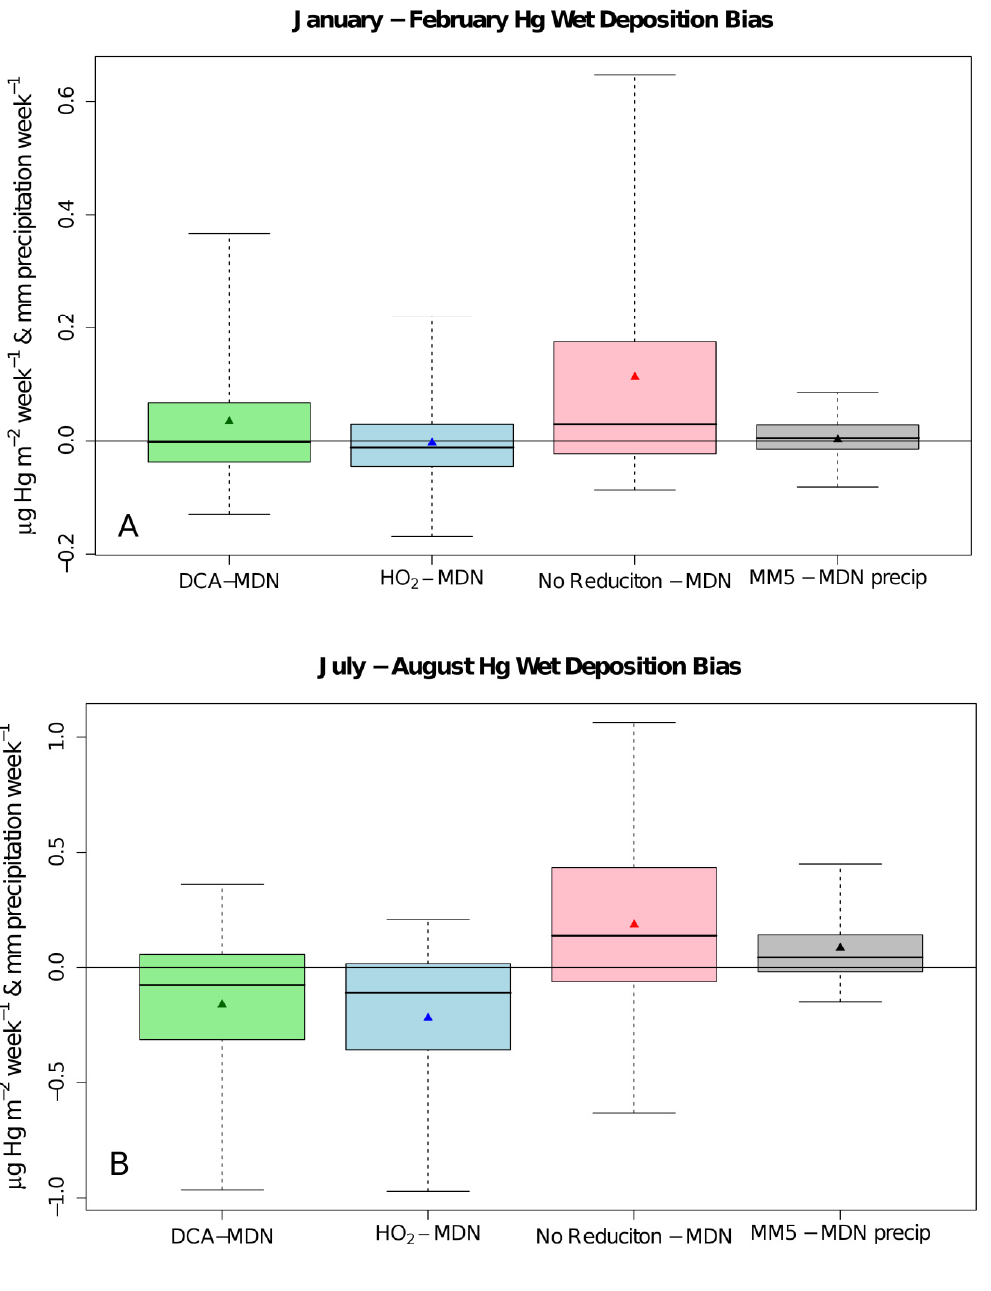
Figure 1. Boxplots of the Community Multiscale Air Quality (CMAQ) modeled bias in the Hg wet deposition and precipitation compared to mercury deposition network (MDN) observations using the DCA (green), HO (blue), and NAR (red) cases and the MM5 2 precipitation (grey) for January and February 2002 ( A ) and July and August 2002 ( B ). The horizontal line through each box is the median bias, the box contains the 25% to 75% and the whiskers extend to the 5th and 95th percentile of the biases, and the triangle is the mean